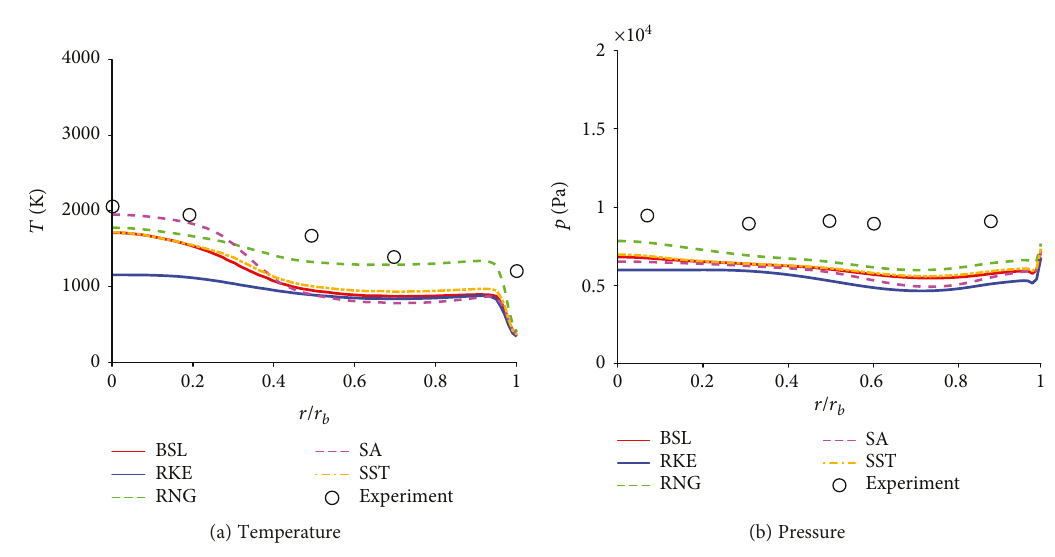
Figure 14: A comparison of radial temperature and pressure at